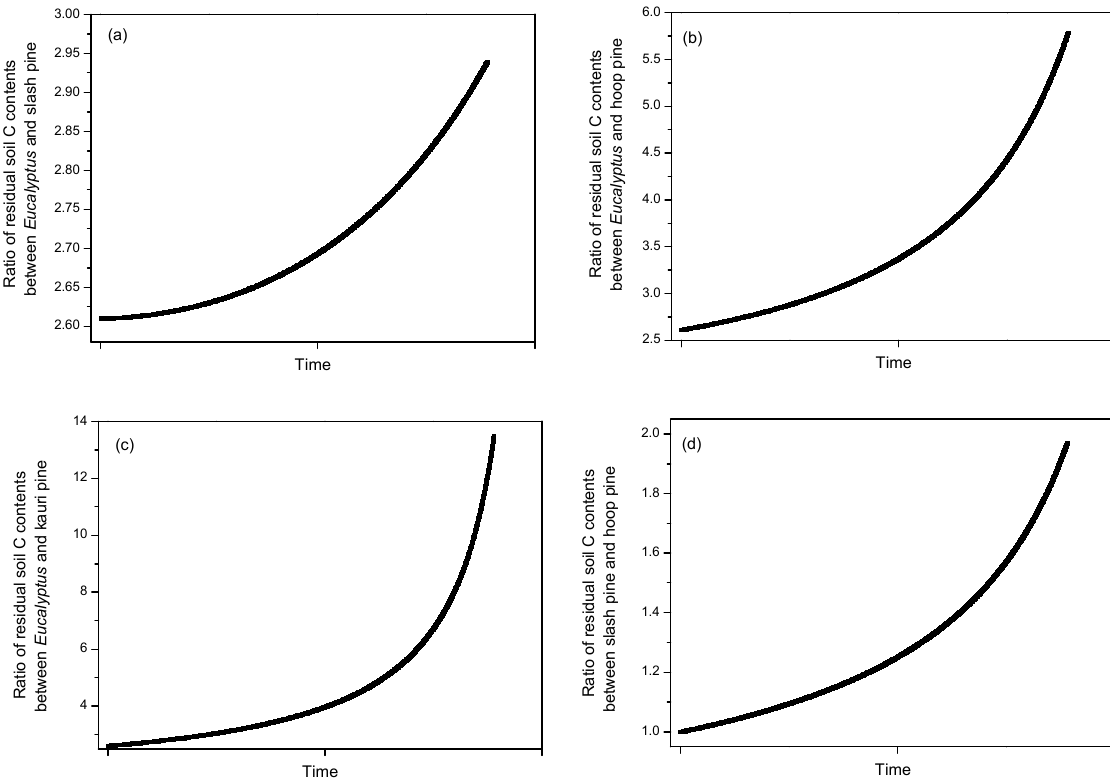
Figure 4. Ratios of residual soil C contents between Eucalyptus and slash pine (a) , between Eucalyptus and hoop pine (b) , between Euca- lyptus and kauri pine (c) and between slash pine and hoop pine (d) for β -glucosidase across time.